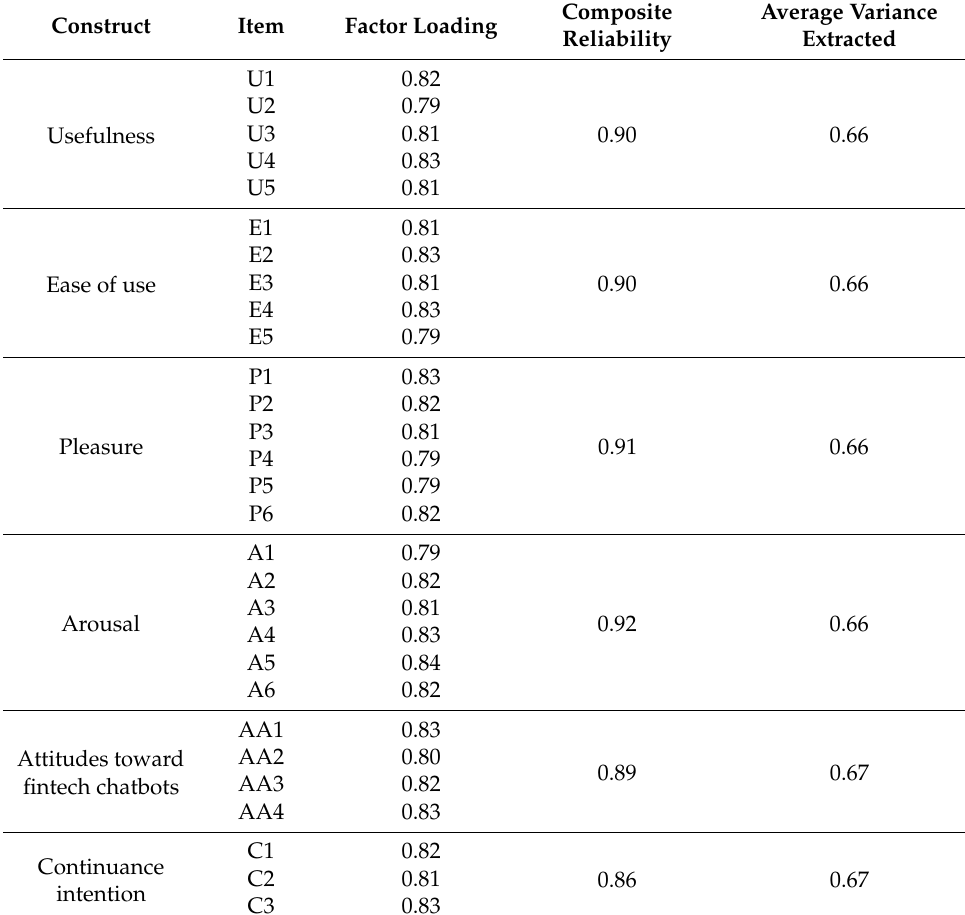
Table 2. The Analysis of Validity and